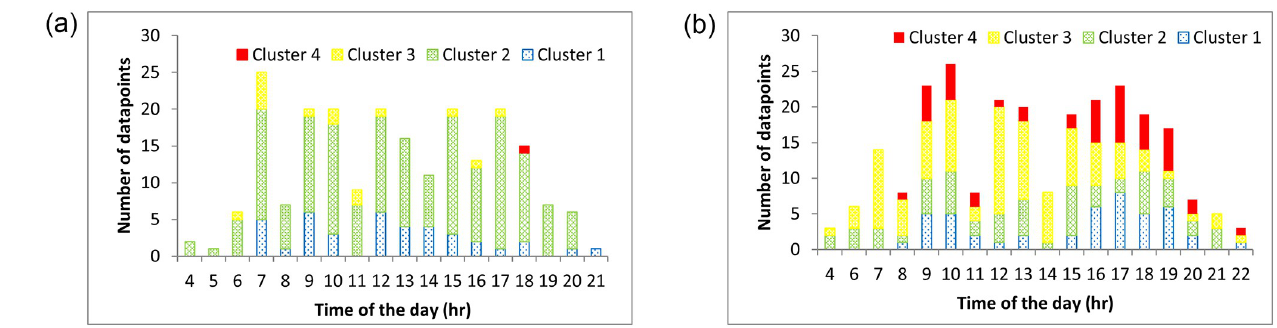
Fig 6. Variation of cluster memberships. (a) Low travel time section, (b) High travel time